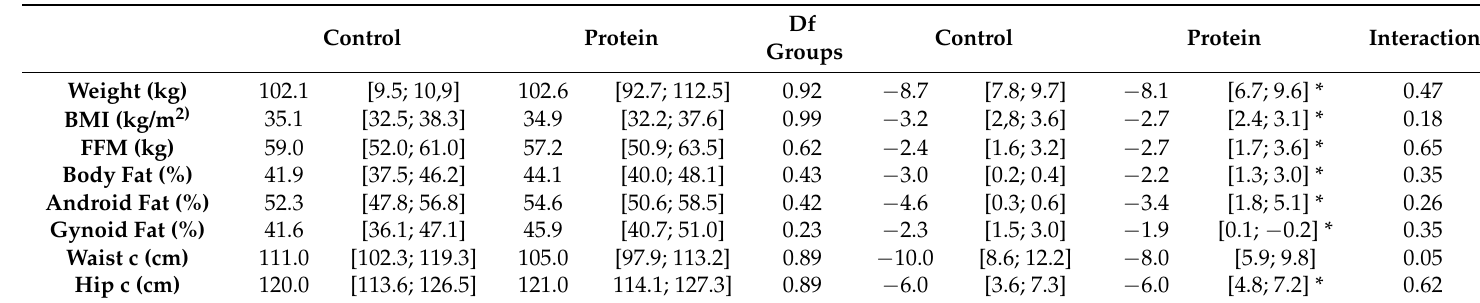
Table 2. Subject characteristics.